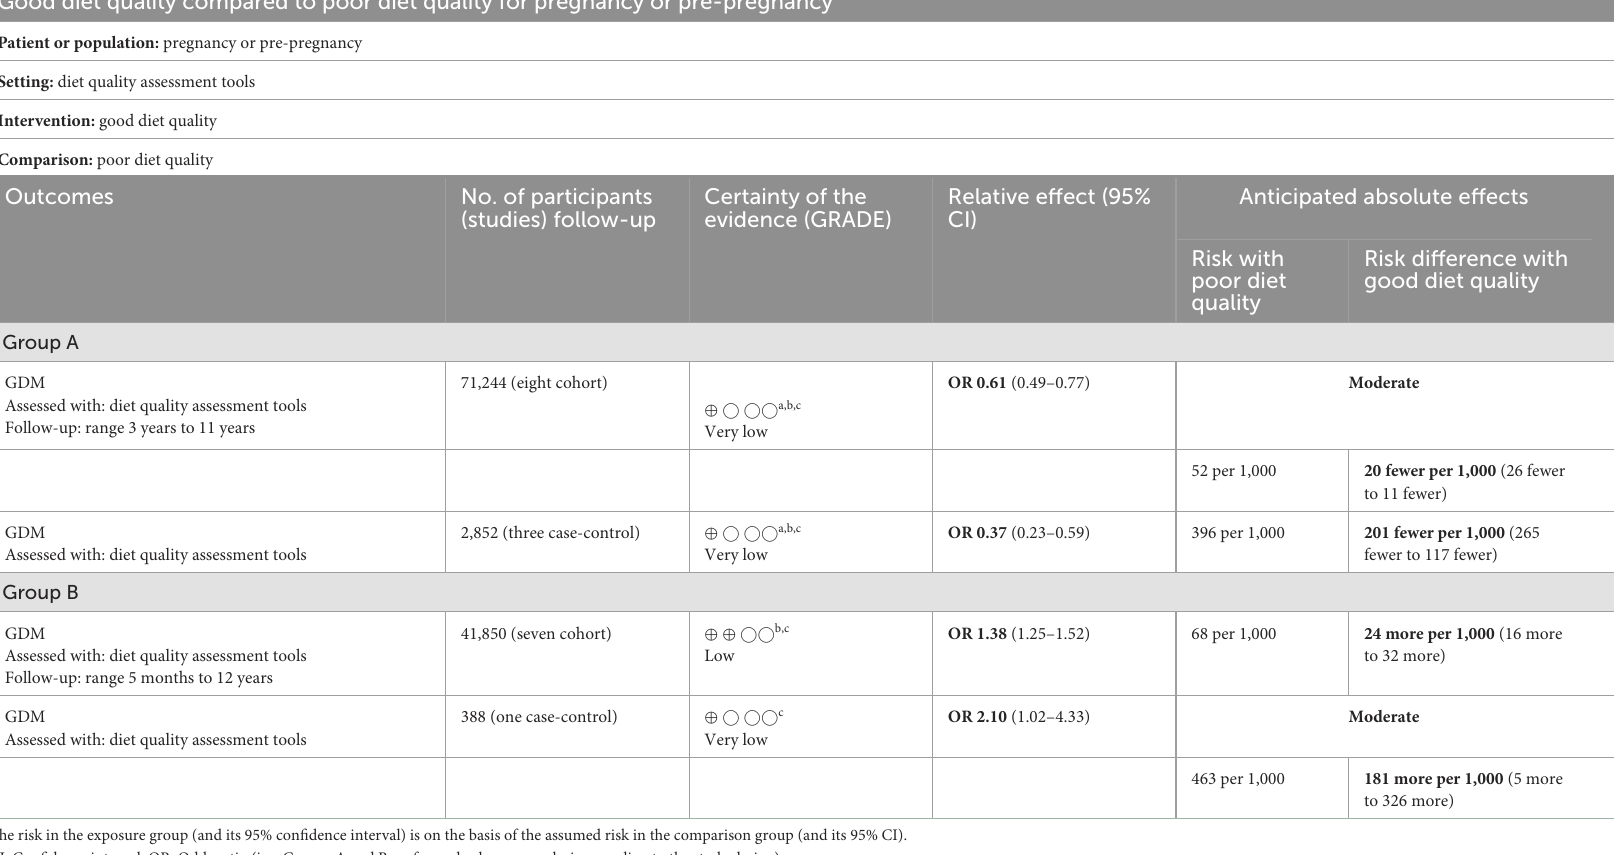
TABLE 2 GRADE assessment of the included